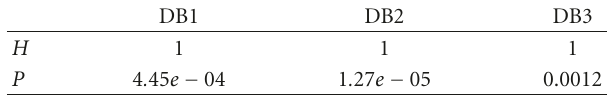
Table 4: Statistic t -tests results of SKI against Chen’s method.